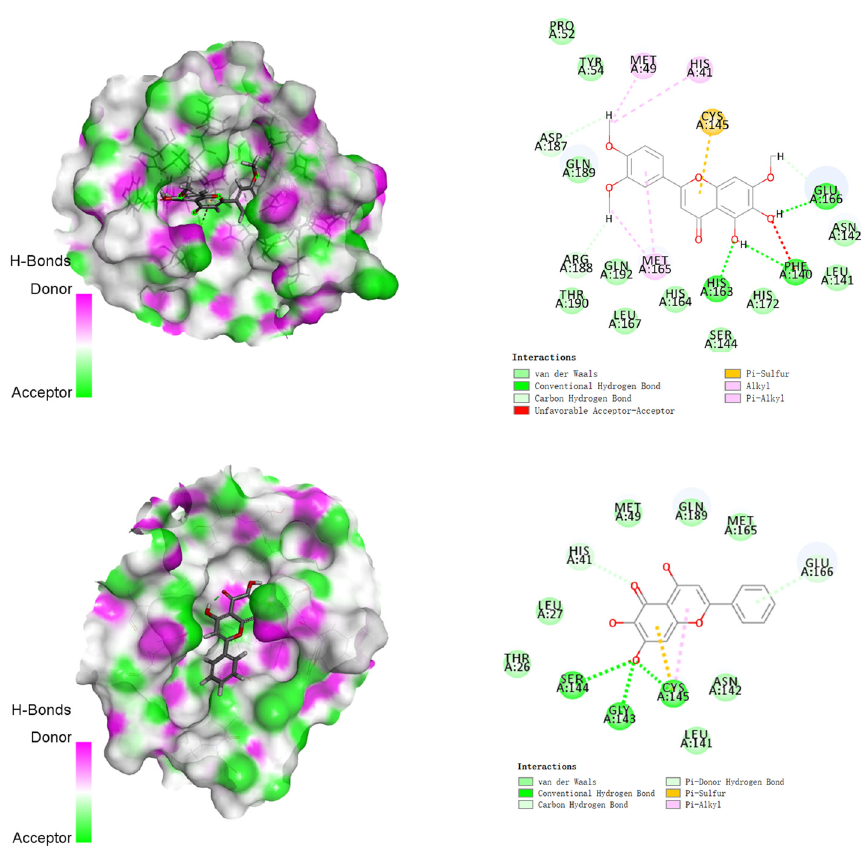
Figure 6. The binding mode of compound 5 – 6 (3D view and 2D view) with 2019-nCoV protease. The carbon atoms of compound 5 and 2019-nCoV protease are represented as grey sticks, and oxygen atoms are shown in red. All the nonbonded interactions are shown in dotted lines with different colors according to their different interaction properties.